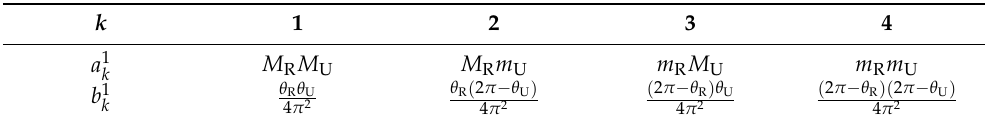
Table 1. Probability mass function of A i .